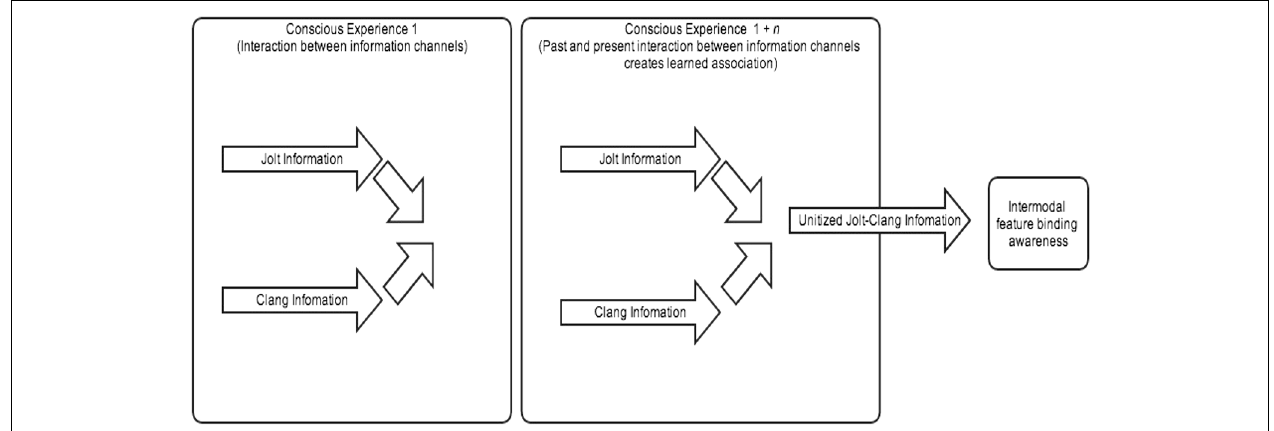
FIGURE 2 | Multimodal perception as an associative learning